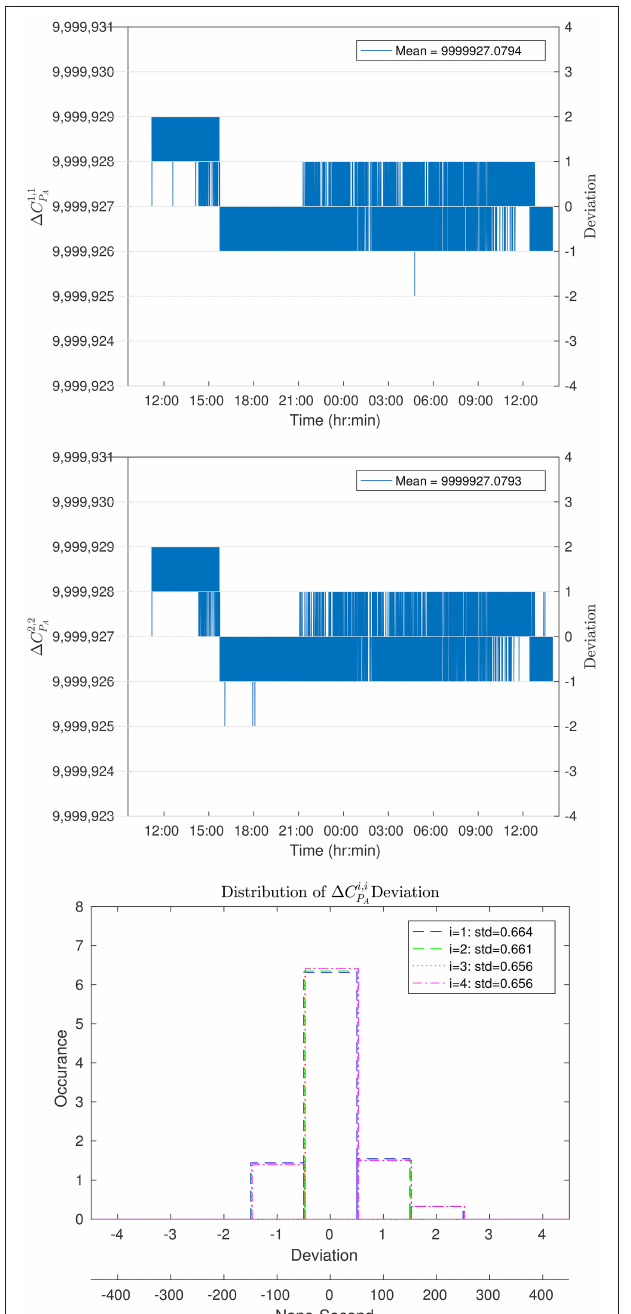
FIGURE 12 | Accuracy of PPS signals from a single GPS module: (top) 1 C 1,1 P , (middle) 1 C 2,2 P A i 1,2,3,4. =